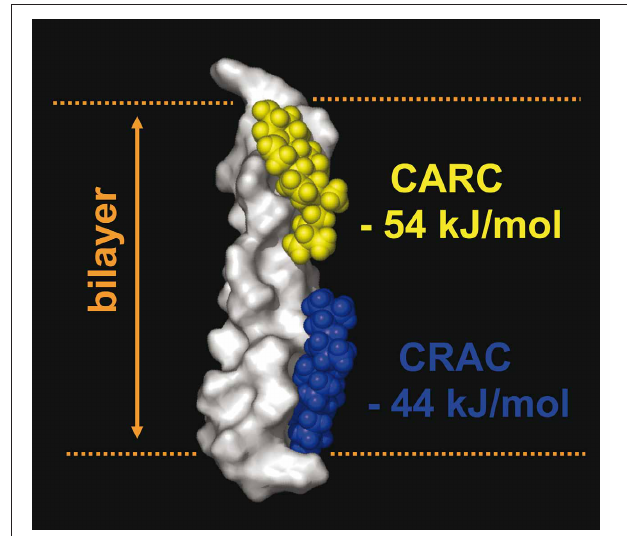
FIGURE 7 | Occurrence of two cholesterol binding motifs (CRAC and CARC) in the same TM domain. An example of the simultaneous occurrence of two cholesterol-recognition motifs in the same TM segment is given by the 5th TM domain of the human type 3 somatostatin receptor, which possesses a CRAC domain in the cytoplasmic leaflet (in blue) and a CARC domain in its exofacial leaflet (in yellow). The calculated energy of interaction of each domain with cholesterol is indicated. The surface rendering of the TM domain is particularly suited to visualize the three-dimensional interaction with cholesterol (rendered as space fill